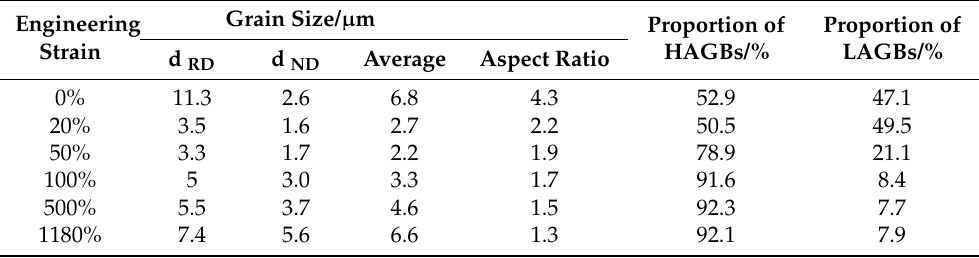
Table 1. Several specific microstructural parameters of the gauge section microstructure with different engineering strains at the optimal superplastic conditions of 500 ◦ C and 1 × 10 − 3 s − 1